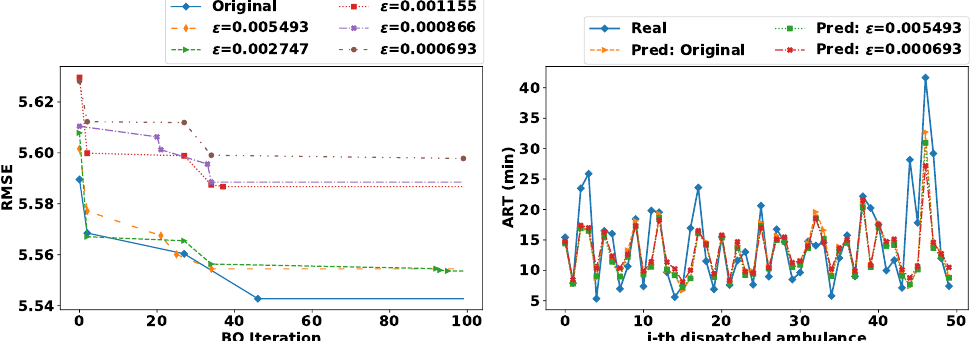
Figure 5. The left-hand plot illustrates the hyperparameters tuning process via Bayesian optimization with 100 iterations for LGBM models trained with original data and sanitized ones. The right-hand plot illustrates the prediction of ARTs with LGBM models trained with original data and with sanitized